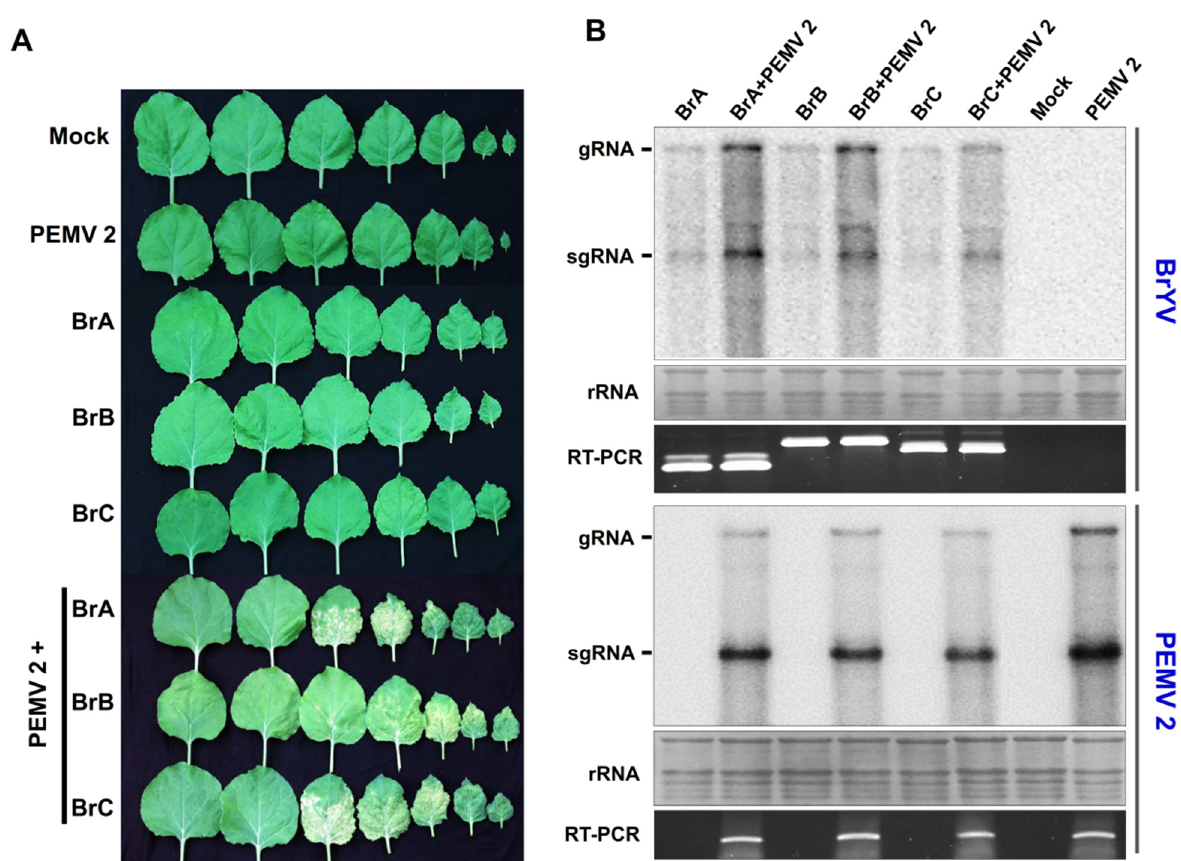
Figure 5. Systemic infection of the three BrYV genotypes and PEMV 2. ( A ) The symptoms of N. benthamiana upper leaves were induced by coinfection with BrYVs and PEMV 2. The upper leaves were photographed at 21 dpi. ( B ) Accumulation of BrYV and PEMV 2 in N. benthamiana upper leaves was analyzed using Northern blotting. The viral genomic RNAs (gRNA) and subgenomic RNAs (sgRNA) are shown on the left of the panel. Methylene blue-stained ribosomal RNA (rRNA) was used as the loading control.